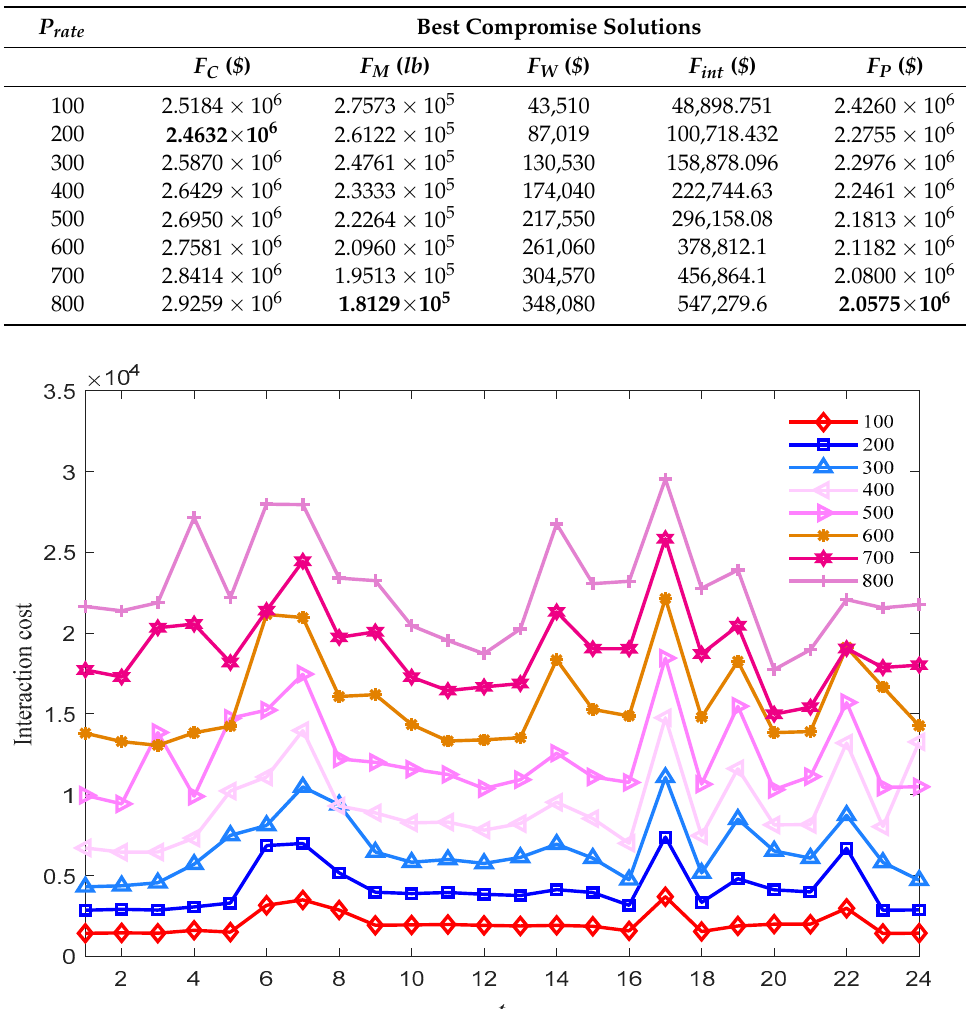
Figure 8. Interaction cost obtained with different wind